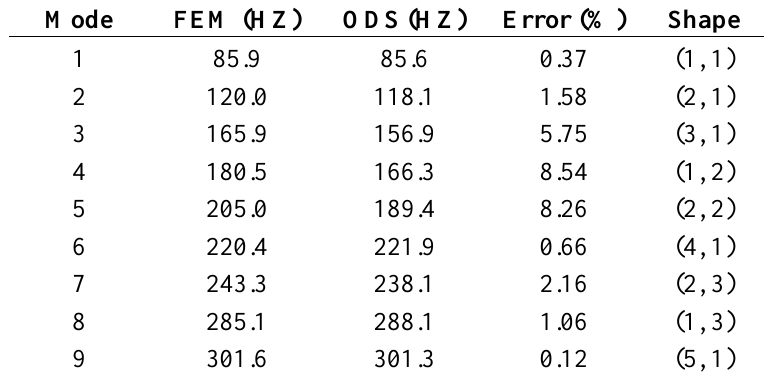
Table 5. Naked Metal Sheet plus Lightweight Multilayer Composite FEM vs. Naked Metal Sheet plus Lightweight Multilayer Composite OSD Frequencies.